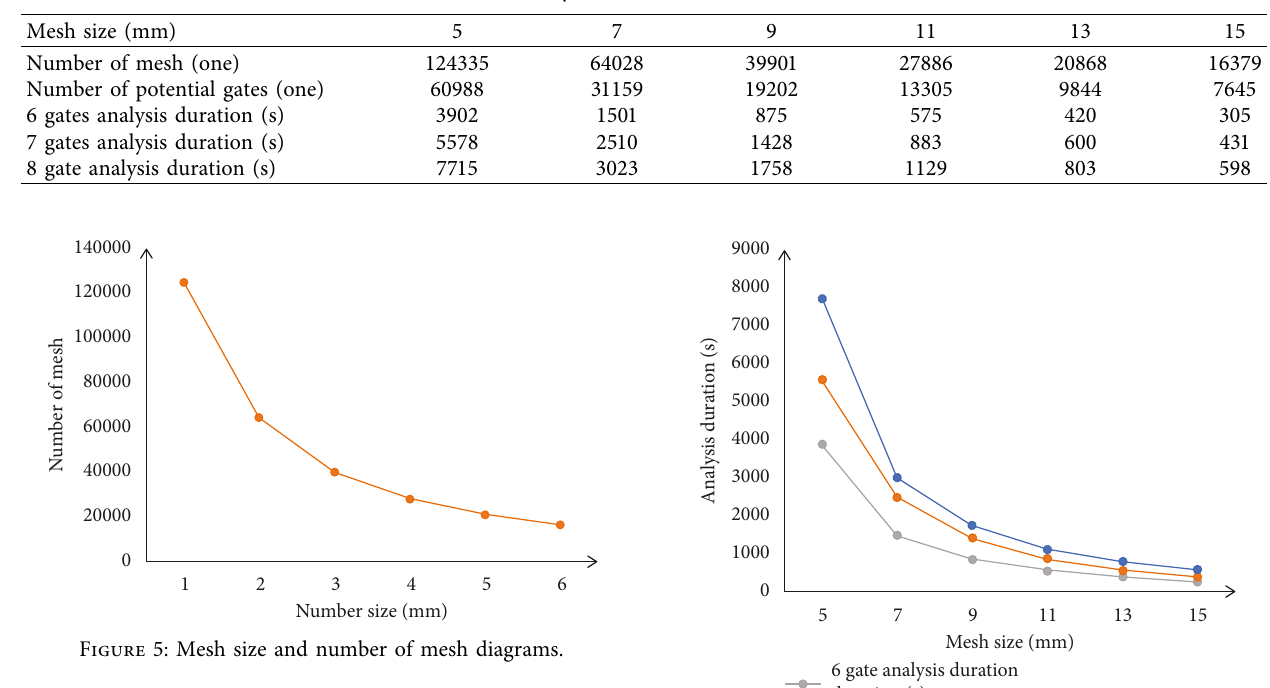
Table 1: Gate analysis information and statistical